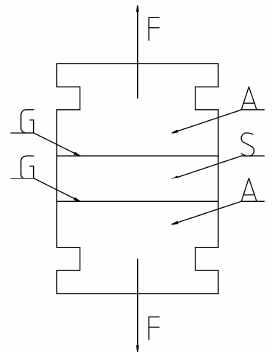
Figure 1. Tool for measuring perpendicular tensile strength in accordance with EN 319 (A—bonded block, S—particleboard specimen, G—glueline, and